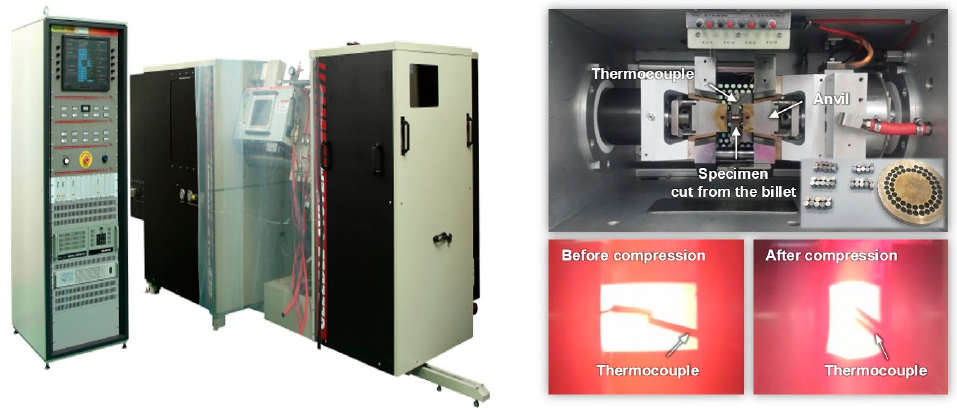
Figure 1. Gleeble 3500 thermomechanical simulator and cylindrical specimens fabricated from the